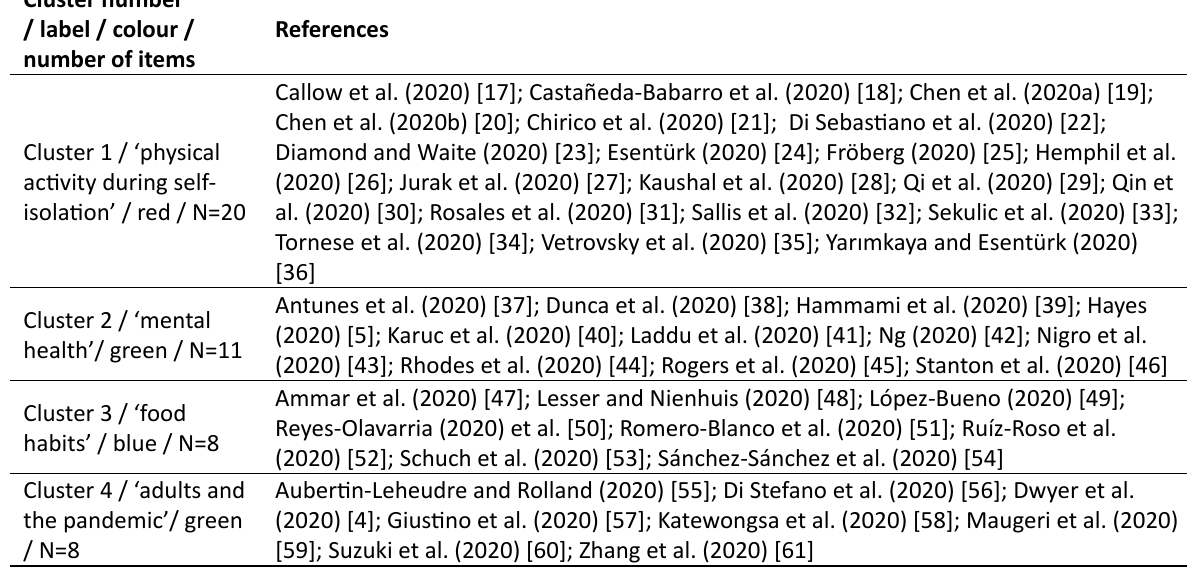
Figure 3. Fronts in research on physical activity in the COVID-19 context (direct citation analysis, cluster density visualisation, weights – citations): Source: Own study based on data retrieved from Scopus and analysed with VOSviewer (15 January Table 4. Clusters of core references in research on physical activity in the COVID-19 context Cluster number